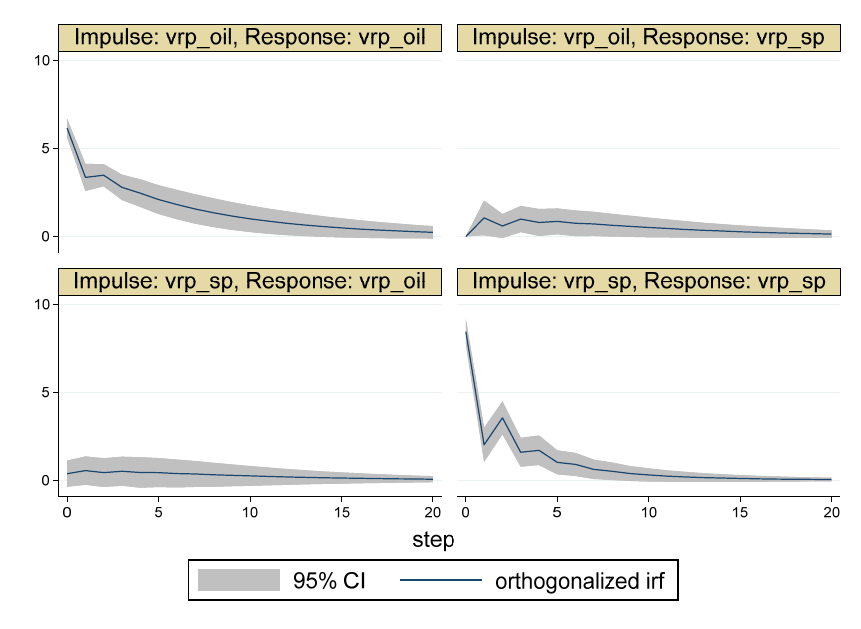
Figure 10. Impulse Response Function with Order VRP (cid:2929)(cid:2926) before VRP (cid:2925)(cid:2919)(cid:2922) (Period 2).